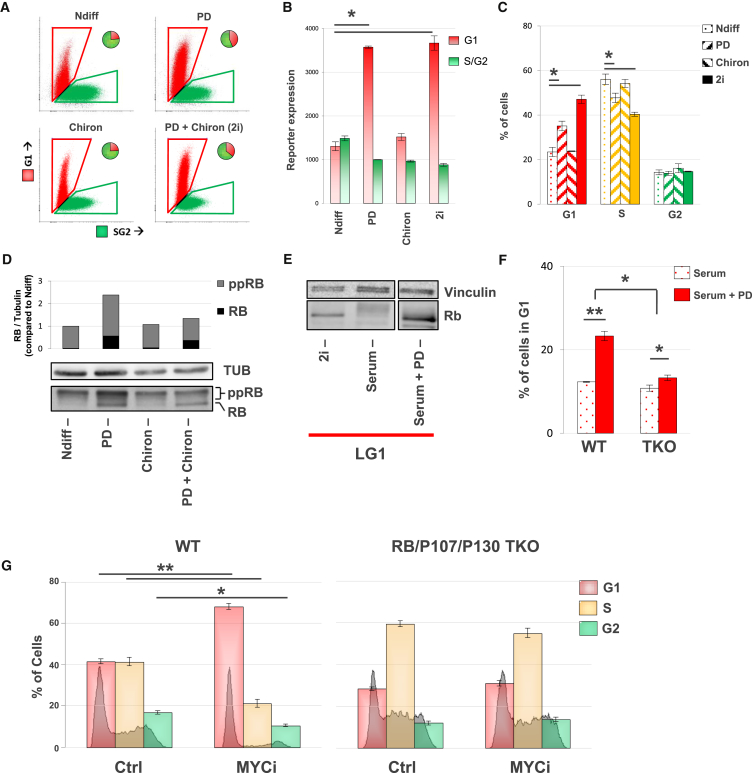
Role of ERK Signaling and RB Family Proteins in Cell-Cycle Regulation in Ground-State ESCs(A) Quantification of G1- and SG2-phases in FUCCI cells in Ndiff medium supplemented with LIF and either PD, Chiron, or both inhibitors.(B) FUCCI reporter expression shows that inhibition of the ERK signaling pathway by PD results in elongation of G1-phase. Significance was assessed by a two-tailed Student’s t test, ∗p < 0.05. At least two independent experiments showed these results.(C) Cell-cycle analysis using PI shows that the addition of PD results in an increase of cells in G1-phase, whereas Chiron had no significant effect (∗p < 0.05, Student’s t test).(D) ESCs cultured in serum-free NDiff medium + LIF supplemented with either one or both inhibitors show the presence of hypo-phosphorylated RB upon inhibition of the ERK signaling pathway by PD and not by Chiron.(E) Exposure of serum ESCs to PD results in hypo-phosphorylated and increased expression of RB. Similar results were observed in two independent experiments.(F) Quantitation of the number of cells in G1-phase of WT serum ESCs and RB/P107/P130 triple-knockout serum ESCs incubated in the presence of PD, showing that elongation of G1-phase required the RB family proteins. Bar graphs indicate mean ± SD. Comparison was performed by two-tailed Student’s t test; ∗p < 0.01; ∗∗p < 0.001; n = 3.(G) Inhibition of MYC by a small-molecule inhibitor, 10058-F4, results in a near-complete block of WT ESCs but not of RB/P107/P130 triple-knockout ESCs cultured in 2i. Error bars represent means ± SD from triplicates, representative of two independent experiments. Significance was assessed by two-tailed Student’s t test; ∗p < 0.001; ∗∗p < 0.0001.The bar charts represent the means ± SD. See also Figure S2.